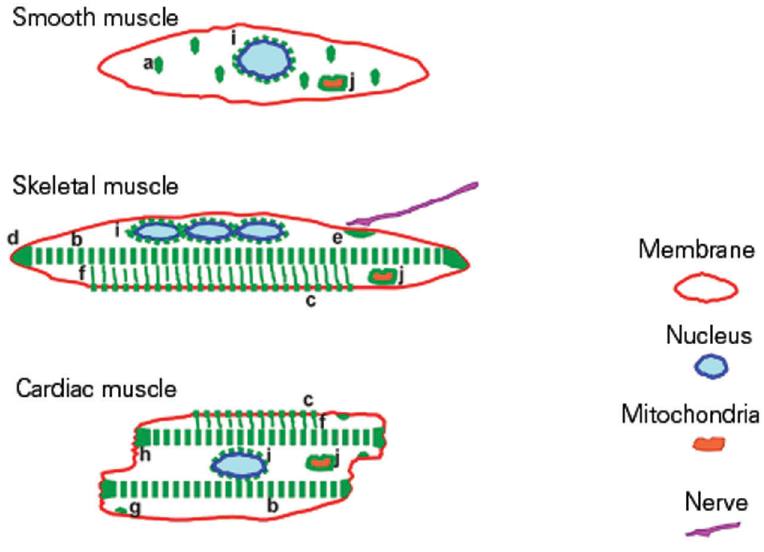
Figure 4. Location of desmin in smooth, skeletal and cardiac muscle types. a , Dense bodies; b , sarcomeres; c , costameres; d , myotendinous junction; e , neuromuscular junc- tion; f , extra-myofibrillar cytoskeleton; g , desmosomes; h , intercalated disk; i , perinuclear position; j,